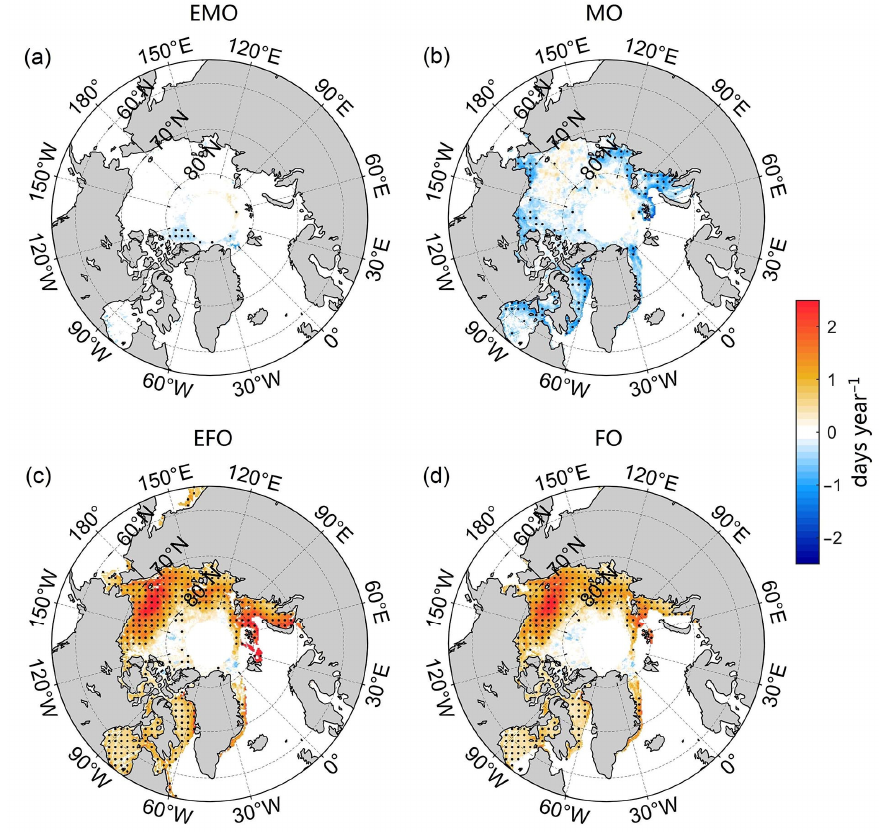
Figure 5. Trend in the satellite-derived sea ice: ( a ) EMO, ( b ) MO, ( c ) EFO, and ( d ) FO for 1982–2018. Black points indicate the trends that are significantly above the 95% confidence